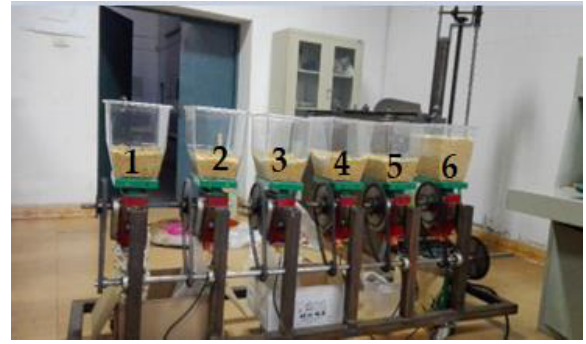
Figure 6. Seeding test platform.